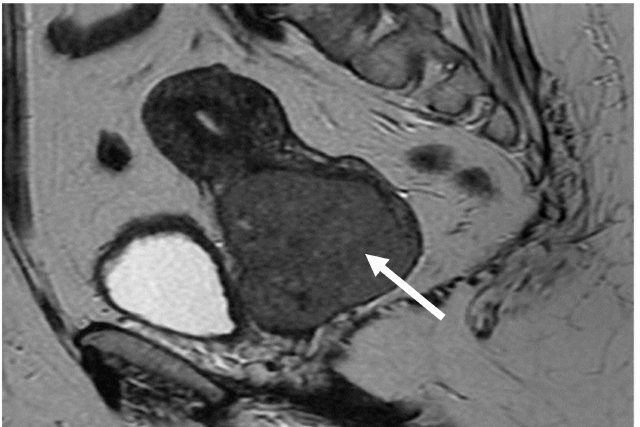
Figure 1. Lymphomatous cervical tumour invading the vaginal cavity: MRI (Magnetic Resonance Imaging)